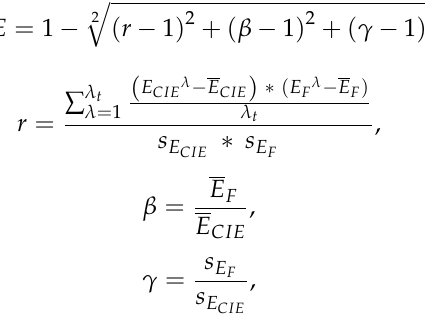
Figure 4. Schematic diagram of the modelling process from the image acquisition to the output re- sult (water body mask and geometrical characteristics such as water body area and water body pe- rimeter). Supplementary Material B presents specific details of WATER.